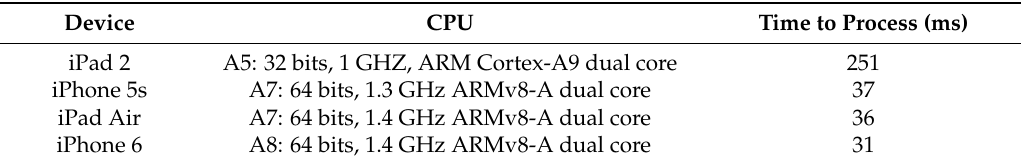
Table 2. Average processing time of the head-tracker with different resolutions on an iPhone 6